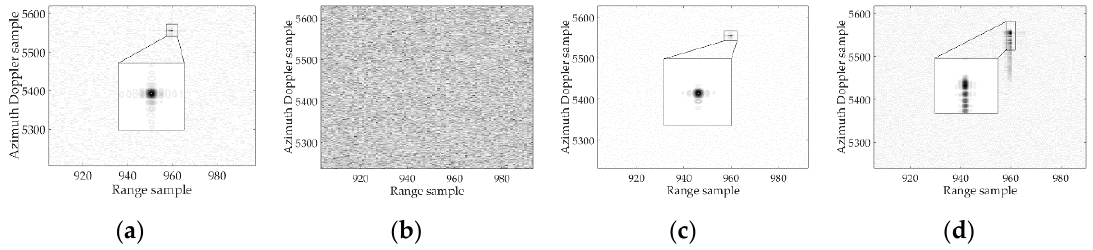
Figure 13. Focusing performance comparison: ( a ) the proposed method; ( b ) the KT based descending stage method [3]; ( c ) the KT based long time coherent integration method [22]; and ( d ) the robust Deramp-Keystone method [23].